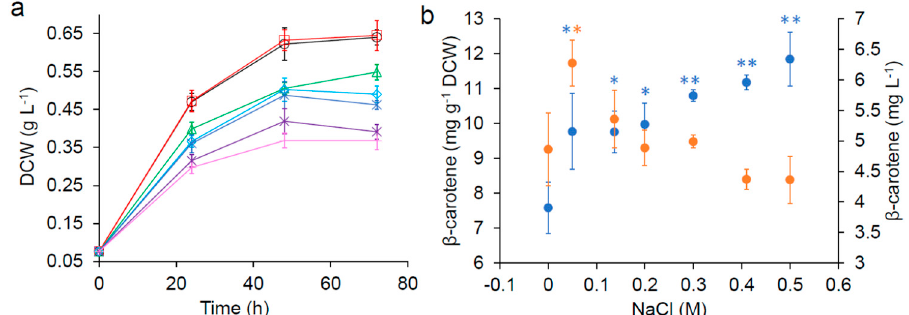
Figure 2. Effect of NaCl supplementation on the growth kinetics and β -carotene production of SM14 in 0.1× YNB media in freshwater. ( a ) growth kinetics (DCW: dry cell weight) with 0 M ( ), 0.05 M ( ), 0.137 M ( ), 0.2 M ( ), 0.3 M ( ), 0.41 M ( ) and 0.5 M ( ) NaCl. ( b ) β -carotene yield ( ) and concentration ( ) after 72 h. Error bars are standard deviations. *: Statistically significantly different from the control (no NaCl) (* p -value < 0.05, ** p -value < 0.01).